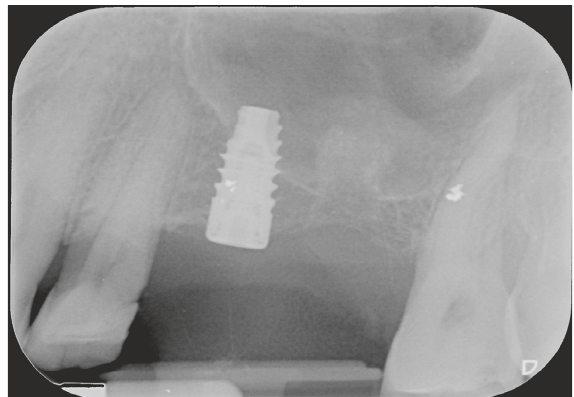
Figure 4: Crestal sinus floor elevation was performed. In the premolar site, collagen sponges were placed, and a 4.25 × 8.5 mm long implant was inserted. In the molar site, a “future site” elevation was achieved with collagen sponges deeply together with a xenograft at the base of the sinus and into the osteotomy.